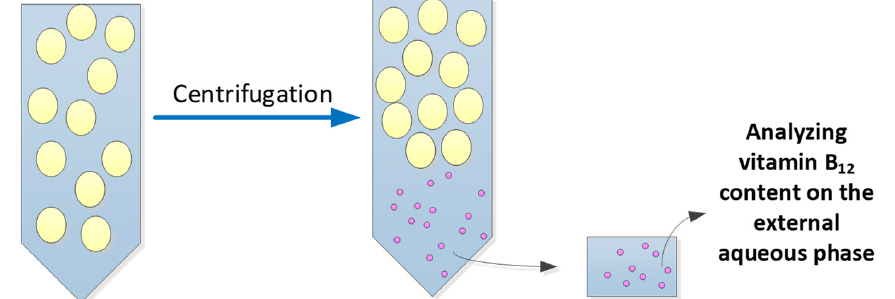
Figure 4. Centrifugation step to obtain continuous phase free of oil droplets.